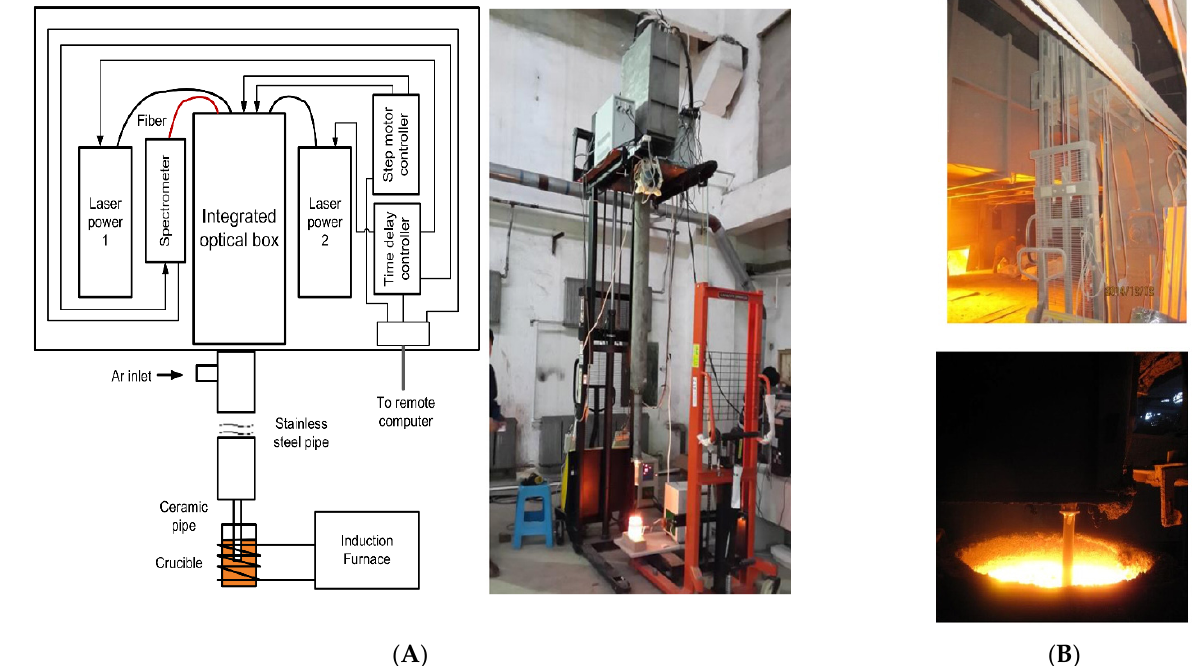
Figure 2. Molten metal analyzing LIBS system developed by Sun et al. [41]. ( A ) Schematic diagram of LIBS system and laboratory photograph and ( B ) steel plant photographs consisting of sealed LIBS setup and refractory lance tip immersed in the ladle of molten steel. (Reprinted from Spectrochimica Acta Part B: Atomic Spectroscopy, vol. 112, Sun, L., Yu, H., Cong, Z., Xin, Y., Li, Y., and Qi, L. In situ analysis of steel melt by double-pulse laser-induced breakdown spectroscopy with a Cassegrain telescope, p. 40–48, 2015. Copyright (2015), with permission from Elsevier).